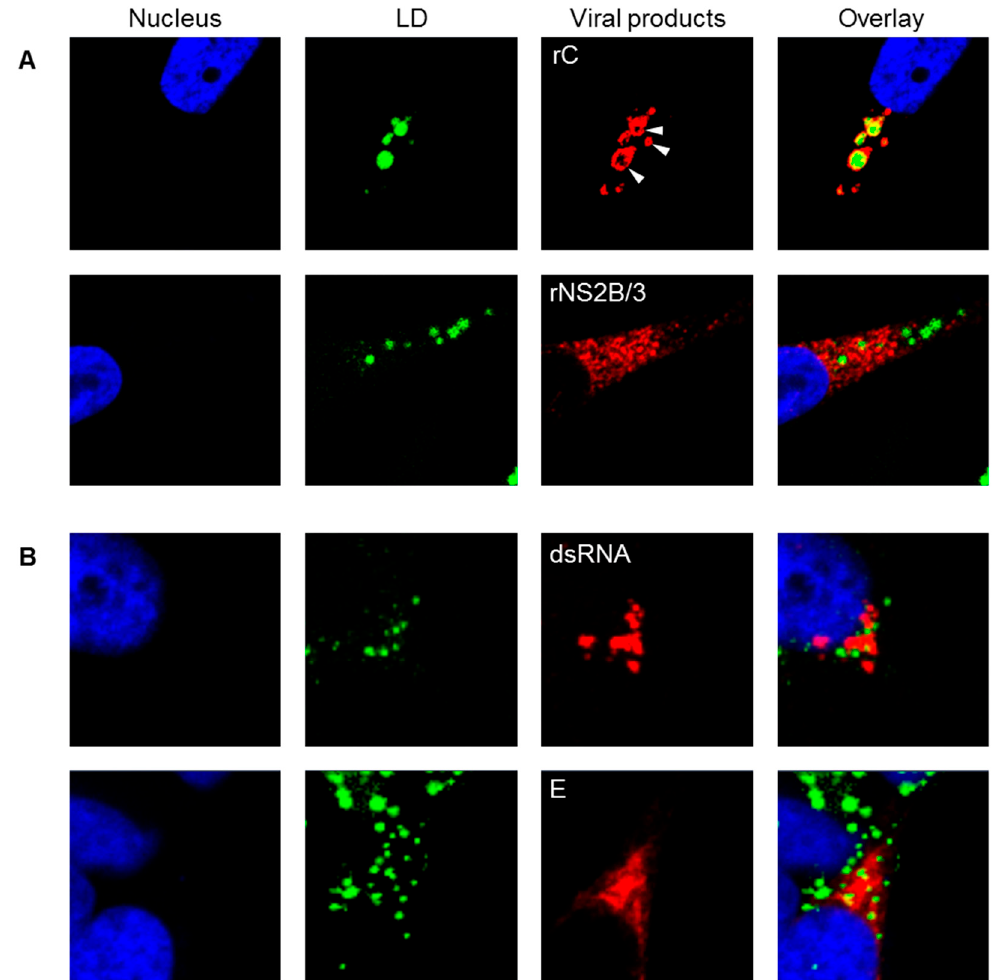
Figure 5. Localization of LD, viral RNA and proteins. ( A ) Expression plasmids containing the cDNA of DENV2 C and NS2B/3 proteins were transiently transfected into HeLa cells. Recombinant proteins were detected with anti-FLAG M2 antibody 48 h after transfection ( B ) HeLa cells were infected with DENV2 16681 strain at MOI 1. Viral dsRNA and E proteins were detected at 48 h p.i. using anti-dsRNA K1 Ab and 12D11/7E8 monoclonal antibodies, respectively. The cellular nucleus and intracellular LD were stained with DAPI and BODIPY 493/503, respectively. Blue, green, and red fluorescence colors indicate the nucleus, LD, and viral products, respectively. White arrow head indicates C proteins that accumulated around LD.